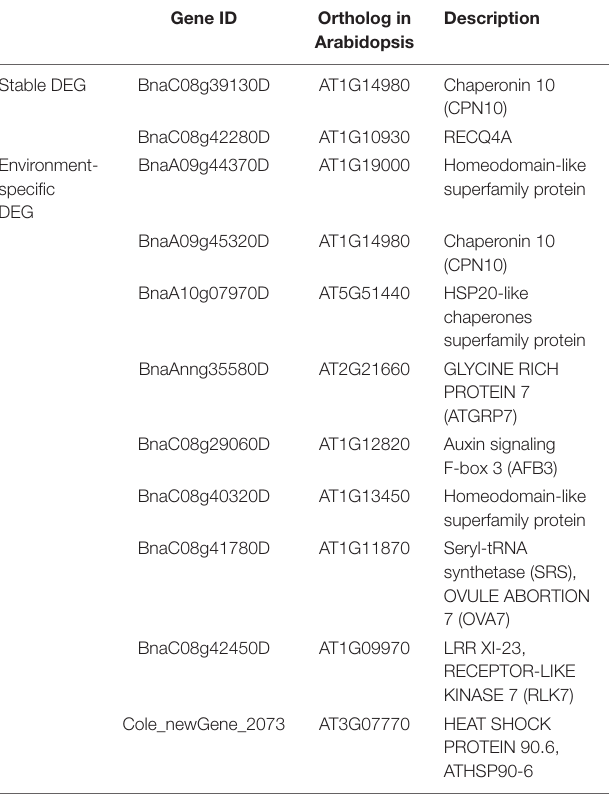
TABLE 3 | Ortholog information for selected stable DEGs and nine environment-specific DEGs. Gene ID Ortholog in Description Arabidopsis